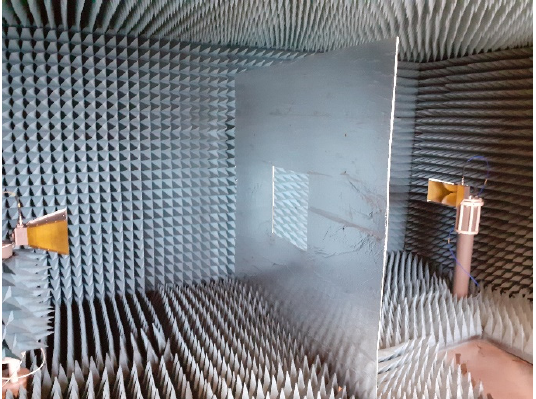
Figure 5. Measurement setup for transmission measurements of the drywall.